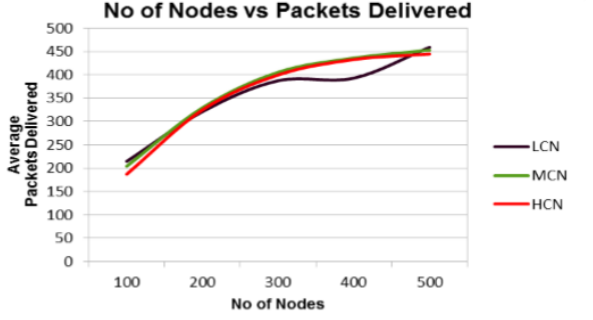
Fig 7: # of Nodes vs. Packet Delivered